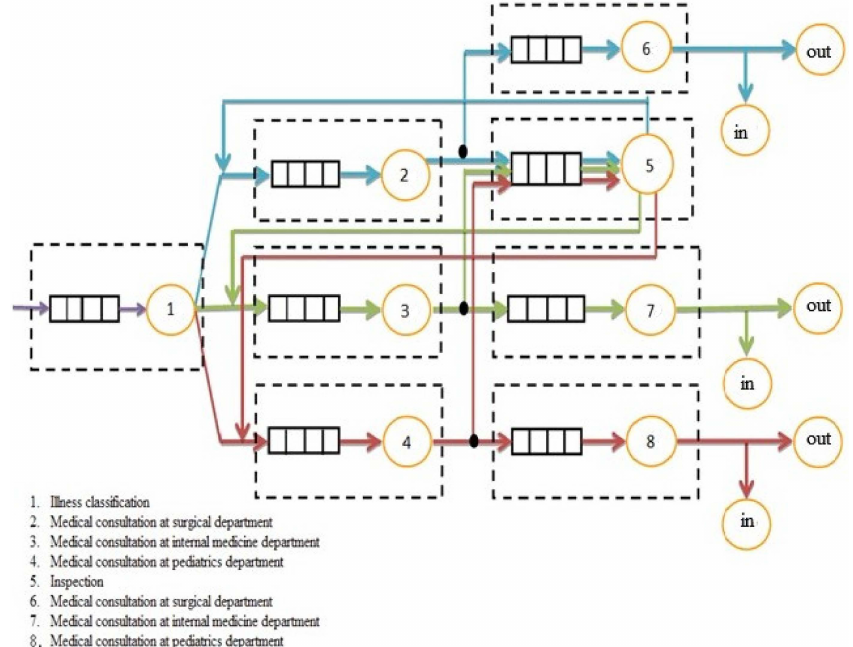
Figure 3. Proposed simulation architecture.